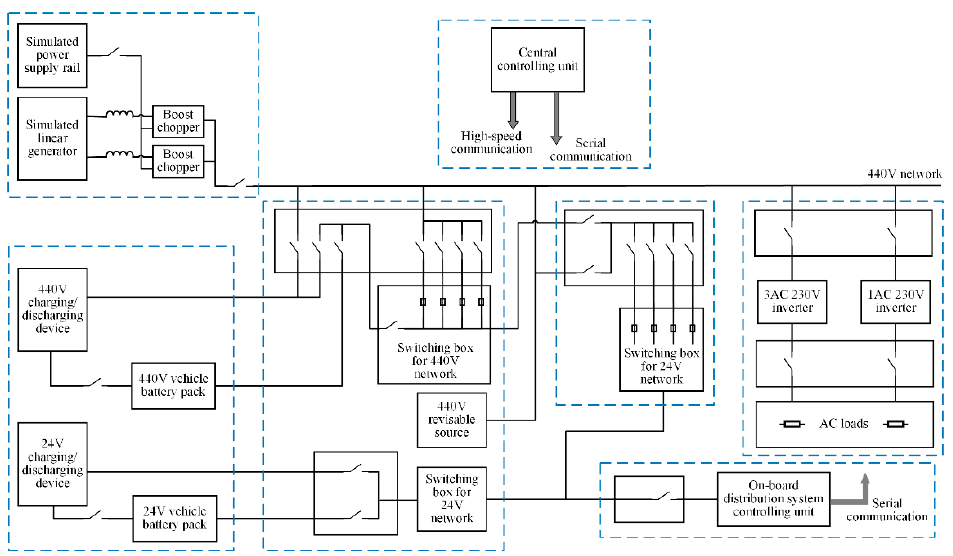
Figure 4. Networking mode of the maglev on-board distribution system.